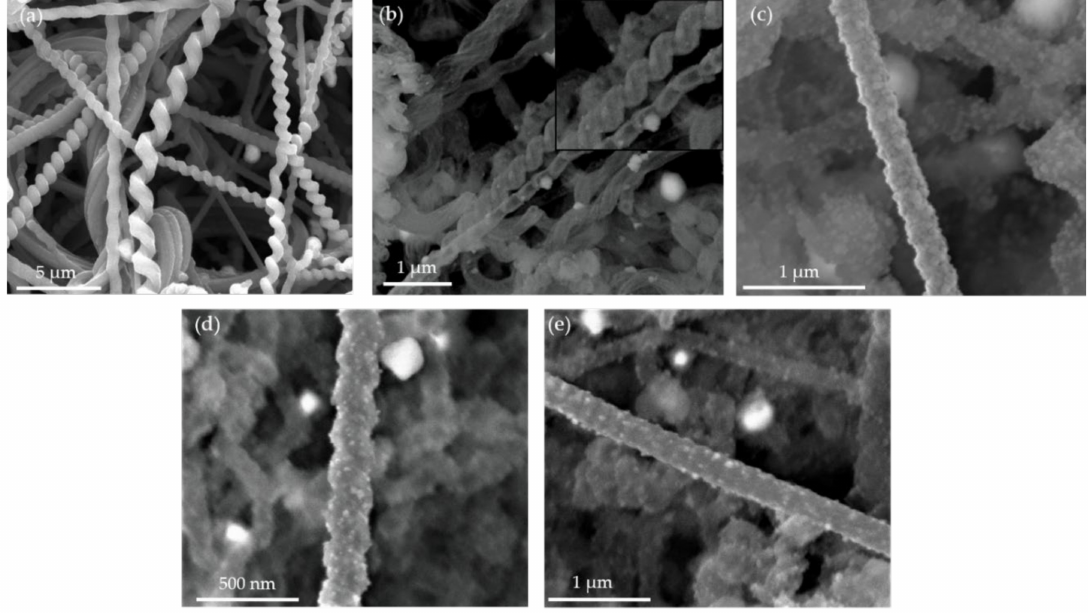
Figure 6. SEM Images of ( a ) as-grown silica nanospring (NS) ensemble showing smooth features, ( b ) 50 cycles GaN on NS with relatively smooth features and little indication of crystalline growth. ( c ) 100 cycles GaN on NS showing clear crystalline growth and NS coated with 50 cycles GaN with bu ff er layers of ( d ) AlN and ( e ) Al 2 O 3 / AlN showing crystallite growth. The large white particles are gold catalyst used during the NS growth process